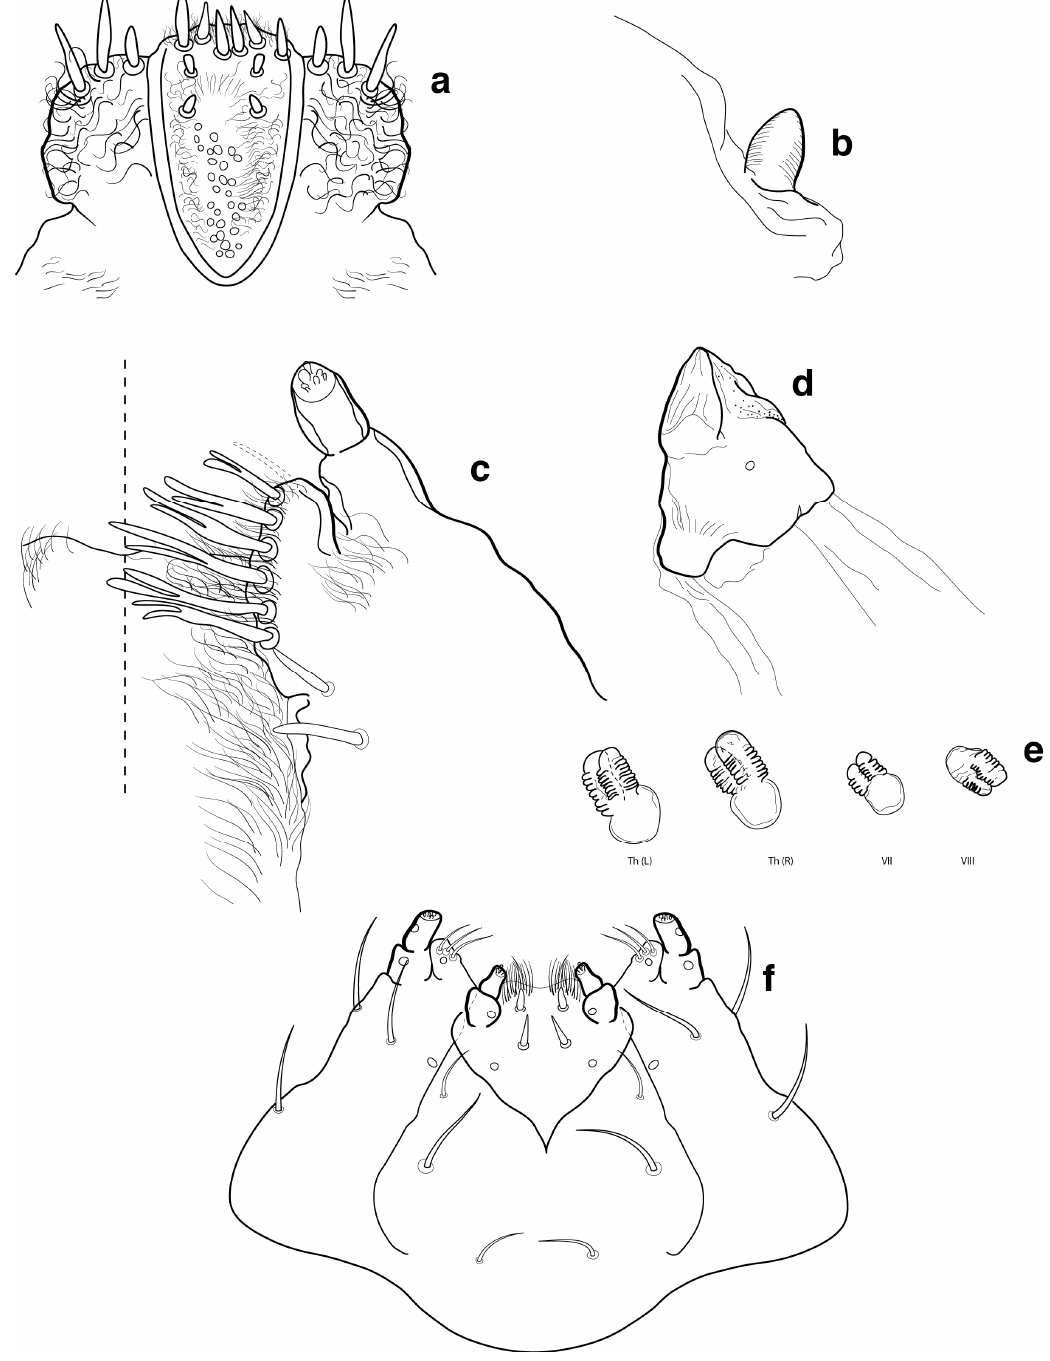
Figure 70. Nephius (= Anius ) pauperatus mouthparts: ( a ) epipharynx; ( b ) antenna, lateral view; ( c ) maxillae and hypopharynx, dorsal view; ( d ) mandible; ( e ) spiracles; and ( f ) labio-maxillary complex, ventral view. Th (L): thorax, left side; Th (R): thorax, right side; VII: 7th abdominal segment; VIII: 8th abdominal segment.